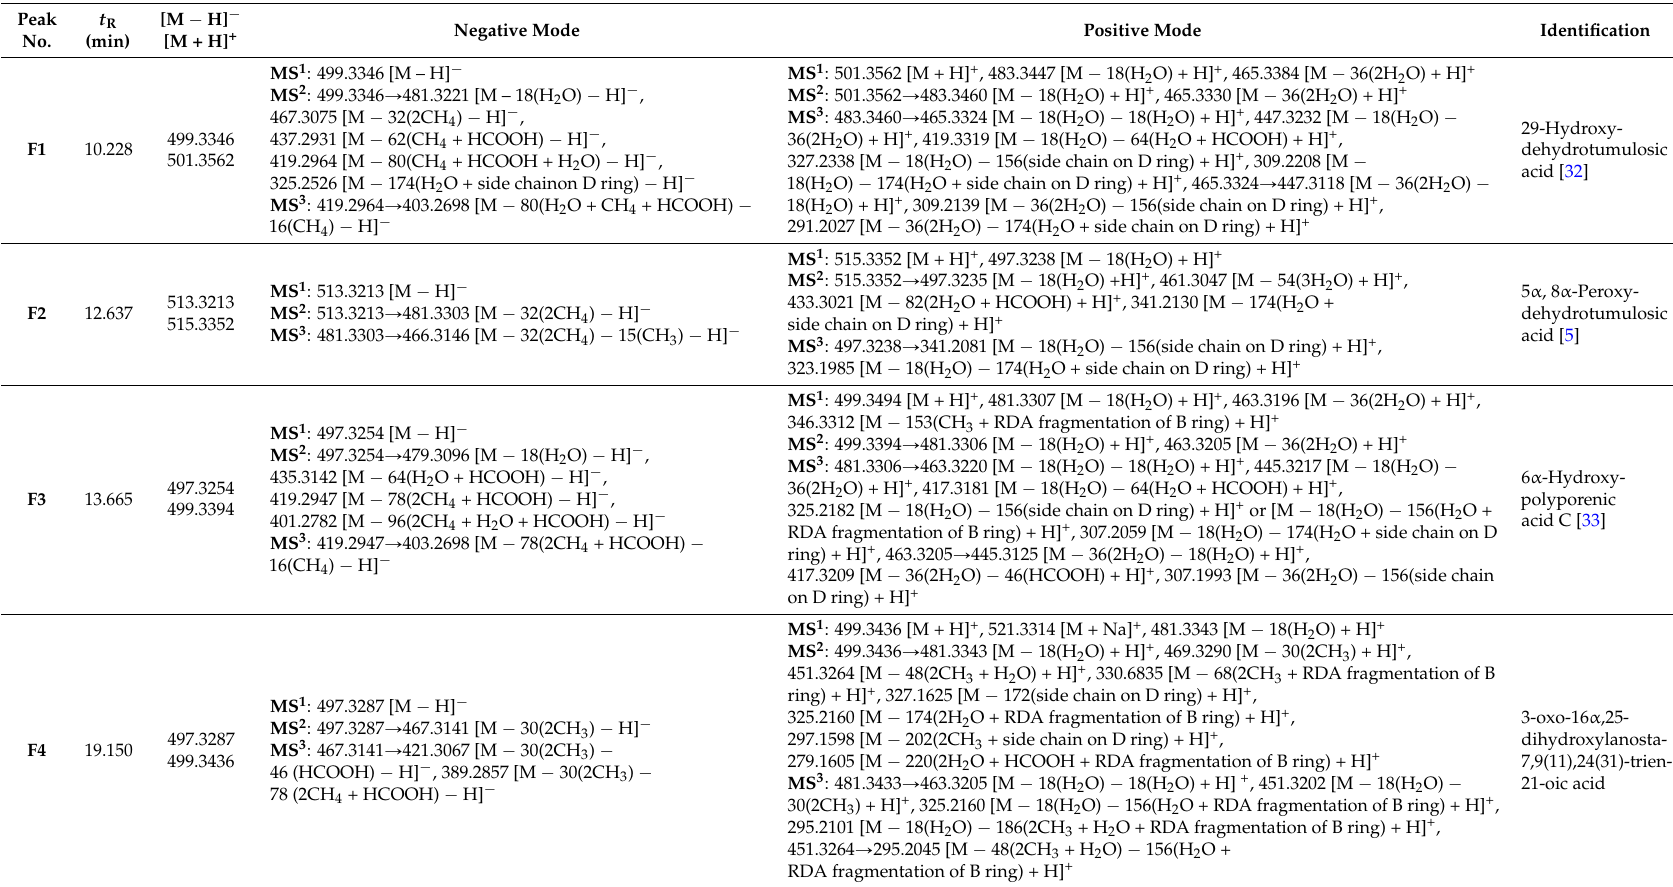
Table 2. The HPLC-MS n data and compound names of the 20